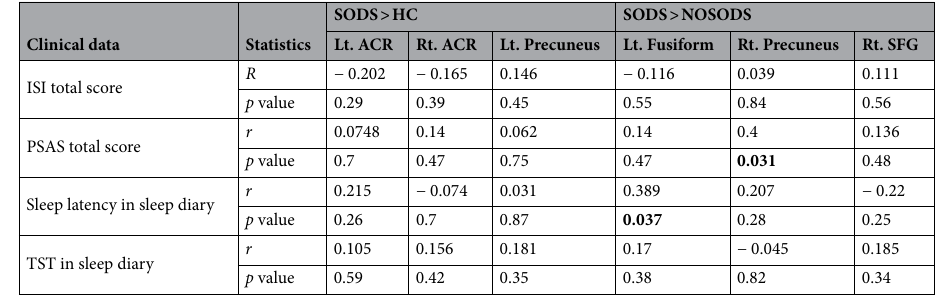
Table 2. Partial correlation results between clinical data and ROI BOLD activation to the Ins vs. Neu contrast. ROI region of interest, BOLD blood oxygen level dependent, Ins insomnia item, Neu neutral item, SODS insomnia with subjective–objective discrepancy of sleep, NOSODS insomnia without subjective–objective discrepancy of sleep, HC healthy control, ACR anterior corona radiate, SFG superior frontal gyrus,